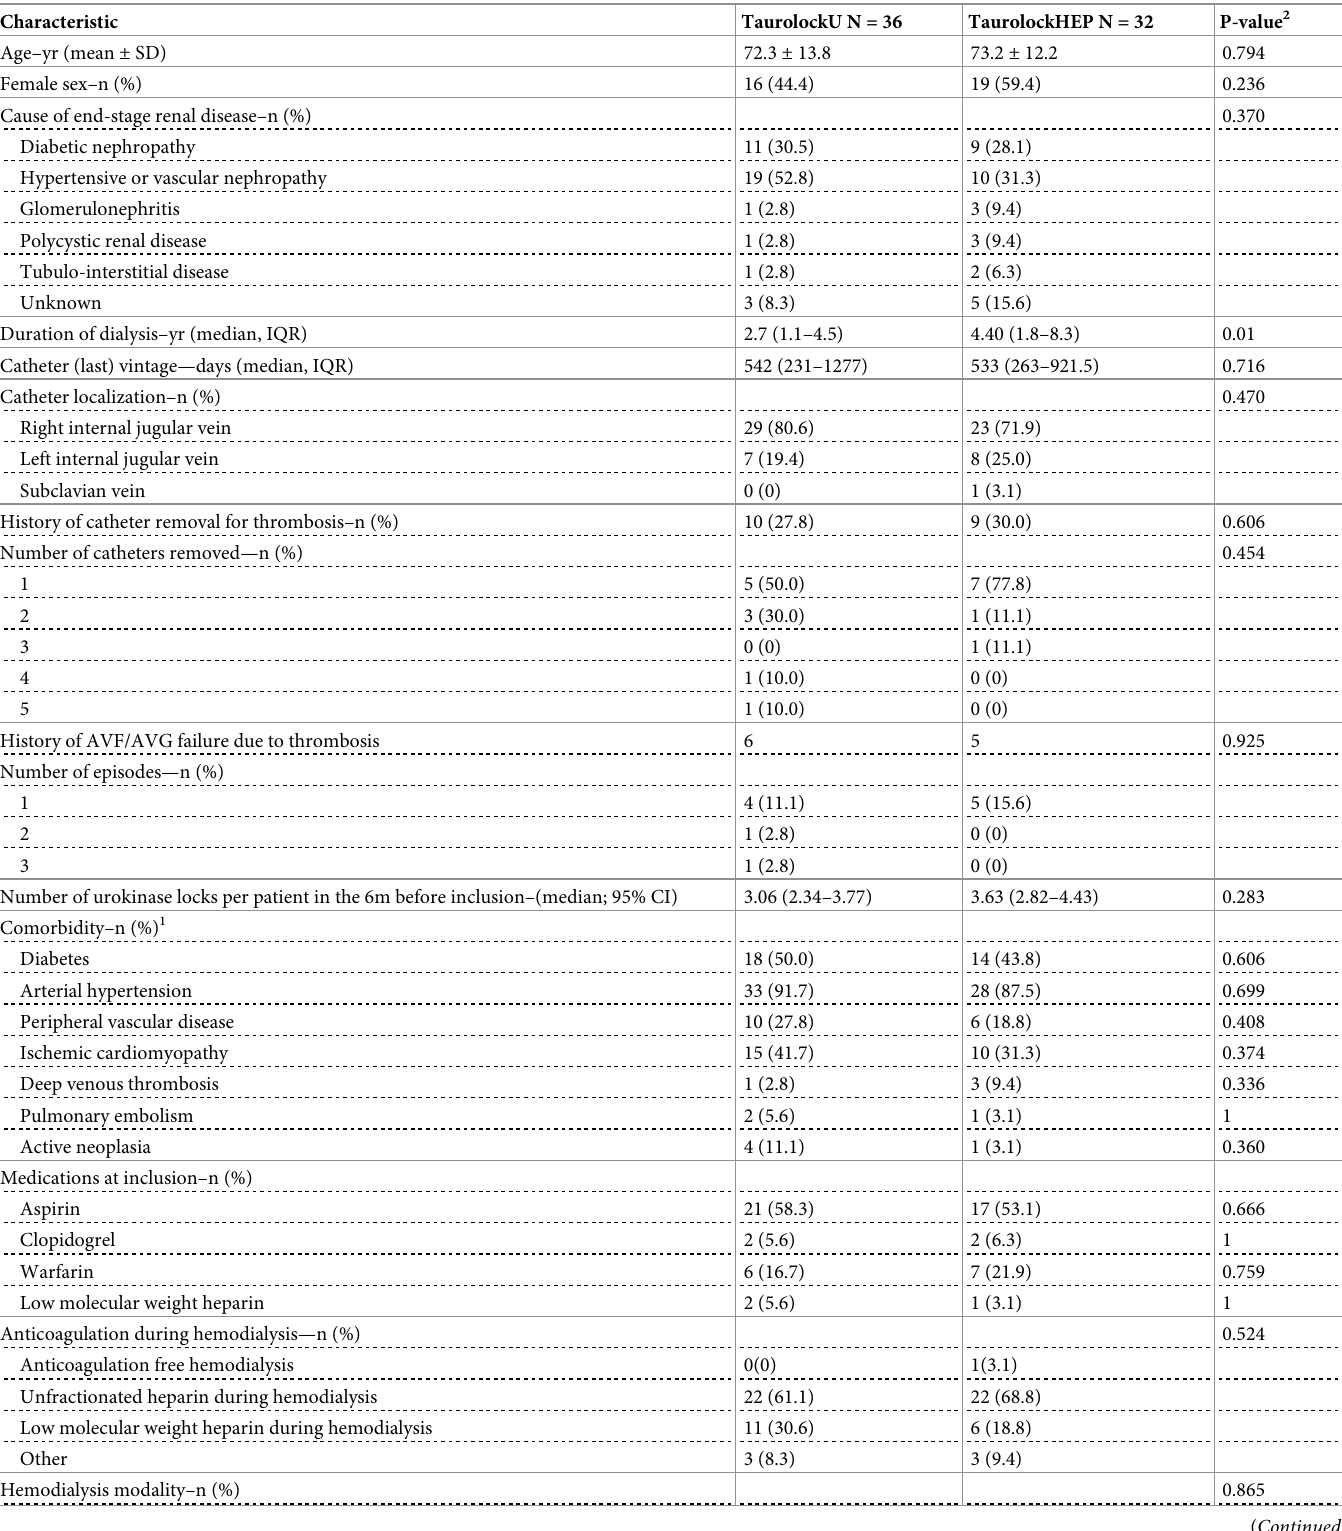
Table 2. Patient